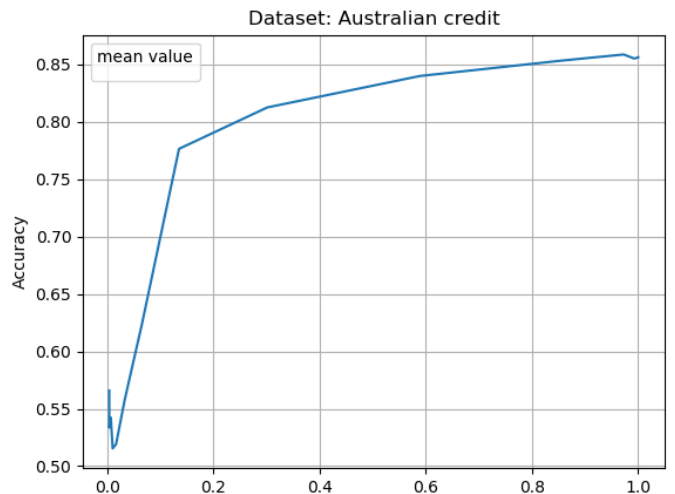
Figure 4. Mean result for 10 learning cycles, using 10 splits; for Australian credit data set; The only way to show the average values from the experiments was to calculate the average accuracy for specific granulation radii. Hence, on the x-axis we have the granulation radii (approximation levels). The figure shows the result from Table